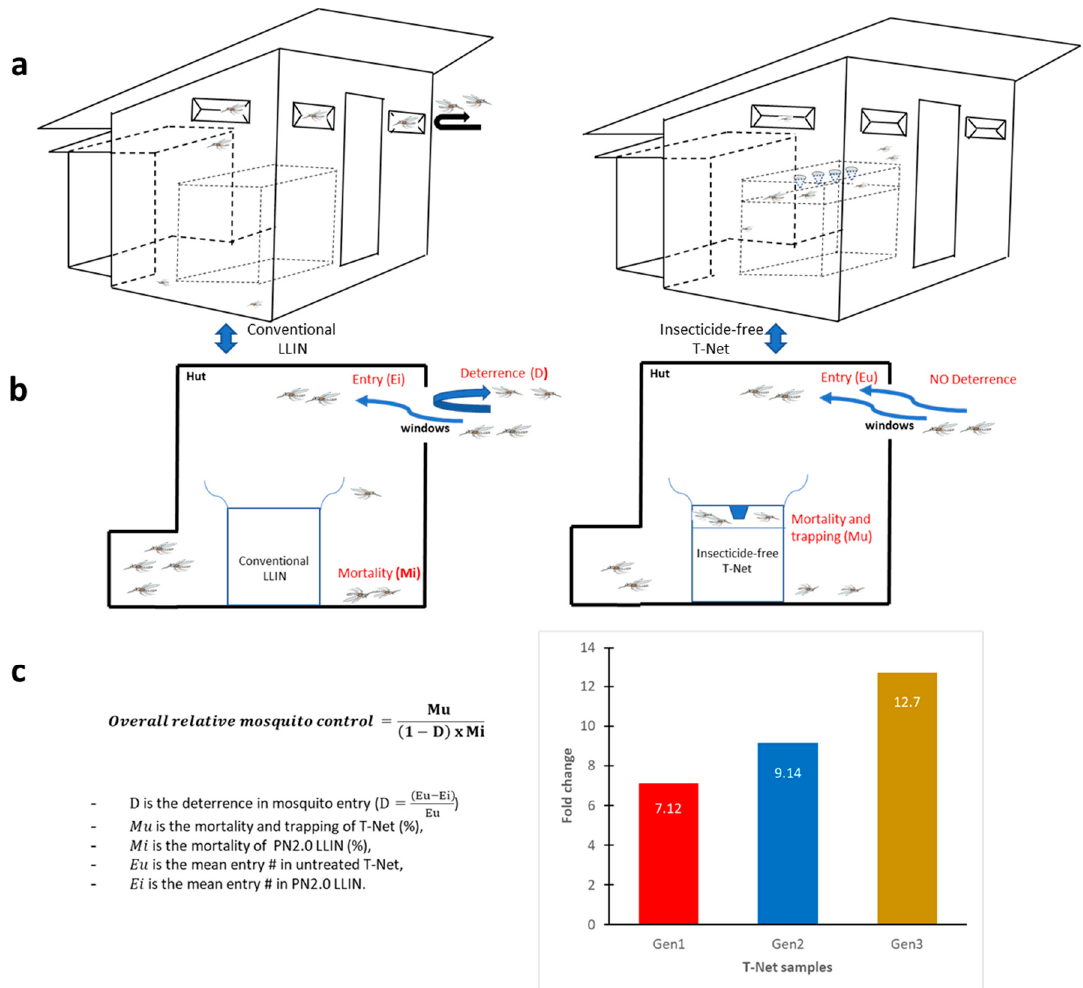
Figure 4. Overall relative mosquito control. ( a ) Schematic illustration of the experimental hut with either a LLIN or a free ‐ insecticide T ‐ net, ( b ) the different parameters used to define the model, and ( c ) overall relative mosquito control. The histograms show the increased mosquito mortality for Gen1, Gen2, and Gen3 T ‐ Nets compared to the PN2.0 ‐ LLIN.